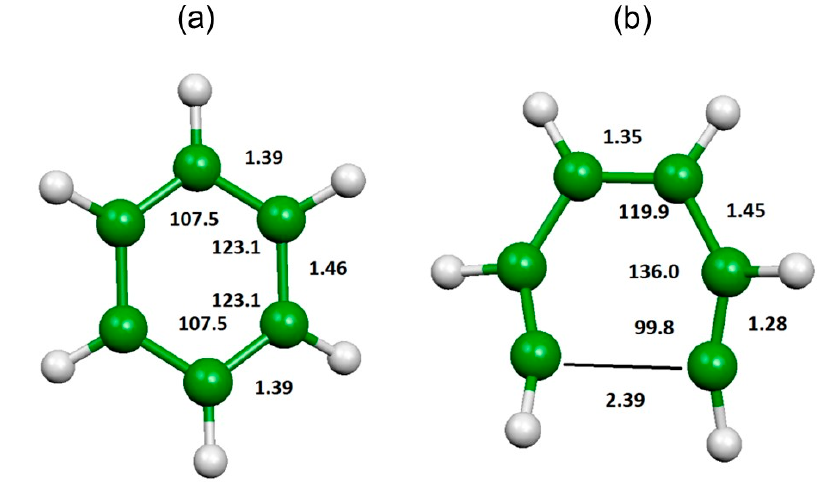
Figure 10. Optimized geometries computed at the B3LYP/6-311+G( d ) level of C 6 H 6+2 ( a ) and the first transition state ( b ) reported in Figure 9. Bond lengths in Å, angles in degrees.